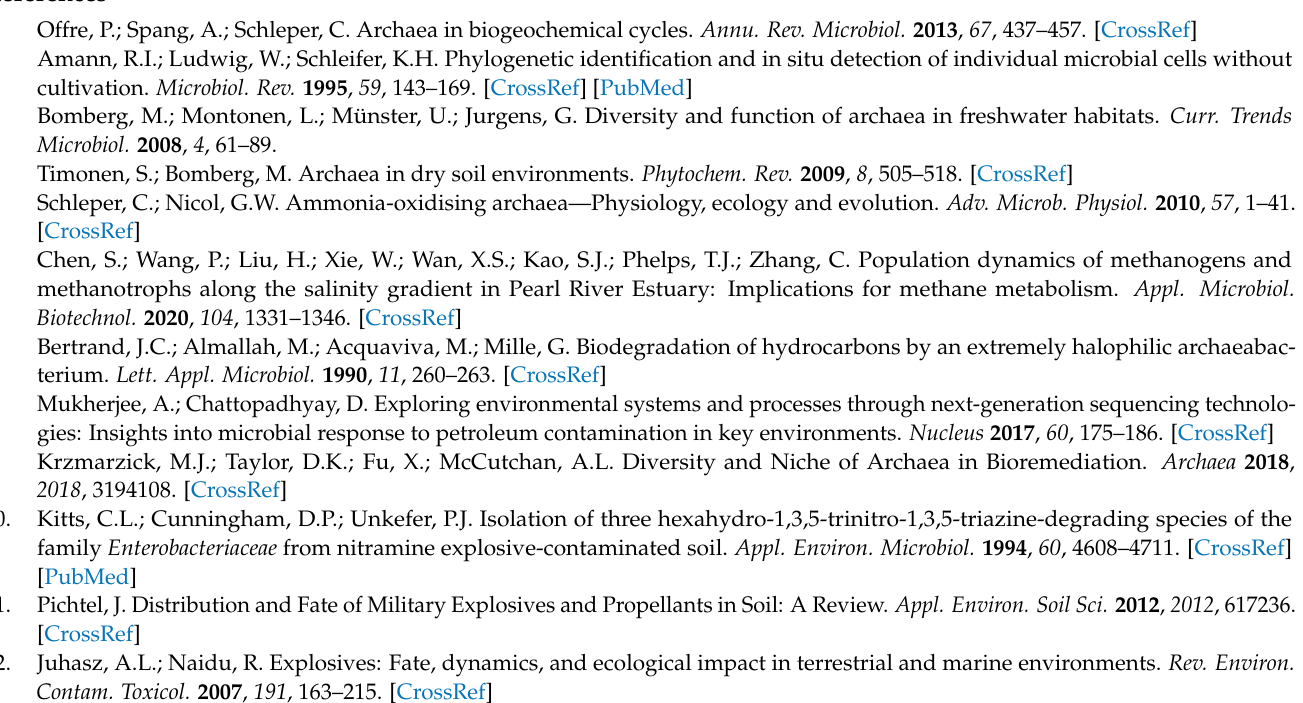
(A) Represent SITE1; (B) SITE2; and (C) Control samples; Figure S5: Bar chart represent family level distribution. (A,B) Represent SITE1; SITE2; and (C) Control samples; Figure S6: Image represent genus level distribution in Control, SITE1 and SITE2 samples; Figure S7: Bubble plot represent core- biome composition in SITE1, SITE2 and control samples; Figure S8: Heatmap represent distribution of metabolic pathways in SITE1, SITE2, and Control (uncontaminated samples C1 & C2) based on KEGG pathways (Hierarchy level 2); Figure S9: Unconstrained PCA plot constructed using linear ordination method represents environmental variables and the archaeal taxa; Figure S10: Non-metric multidimensional scaling (NMDS) plot at phylum level; Table S1: Table represent different diversity Indices for SITE1, SITE2 and control samples; Table S2: Table represents the total number of paired end reads, processed reads, total number of OTU’s picked and the identified archaeal OTUs in SITE 1, SITE 2 and control